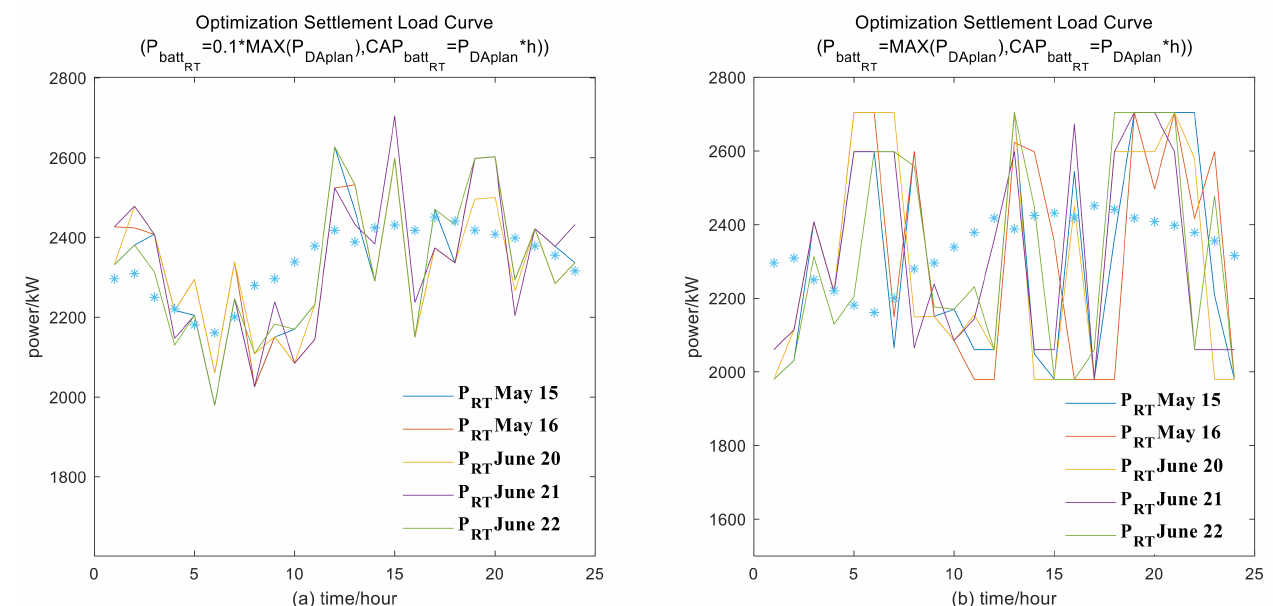
Figure 10. Load control command on real-time operation day.